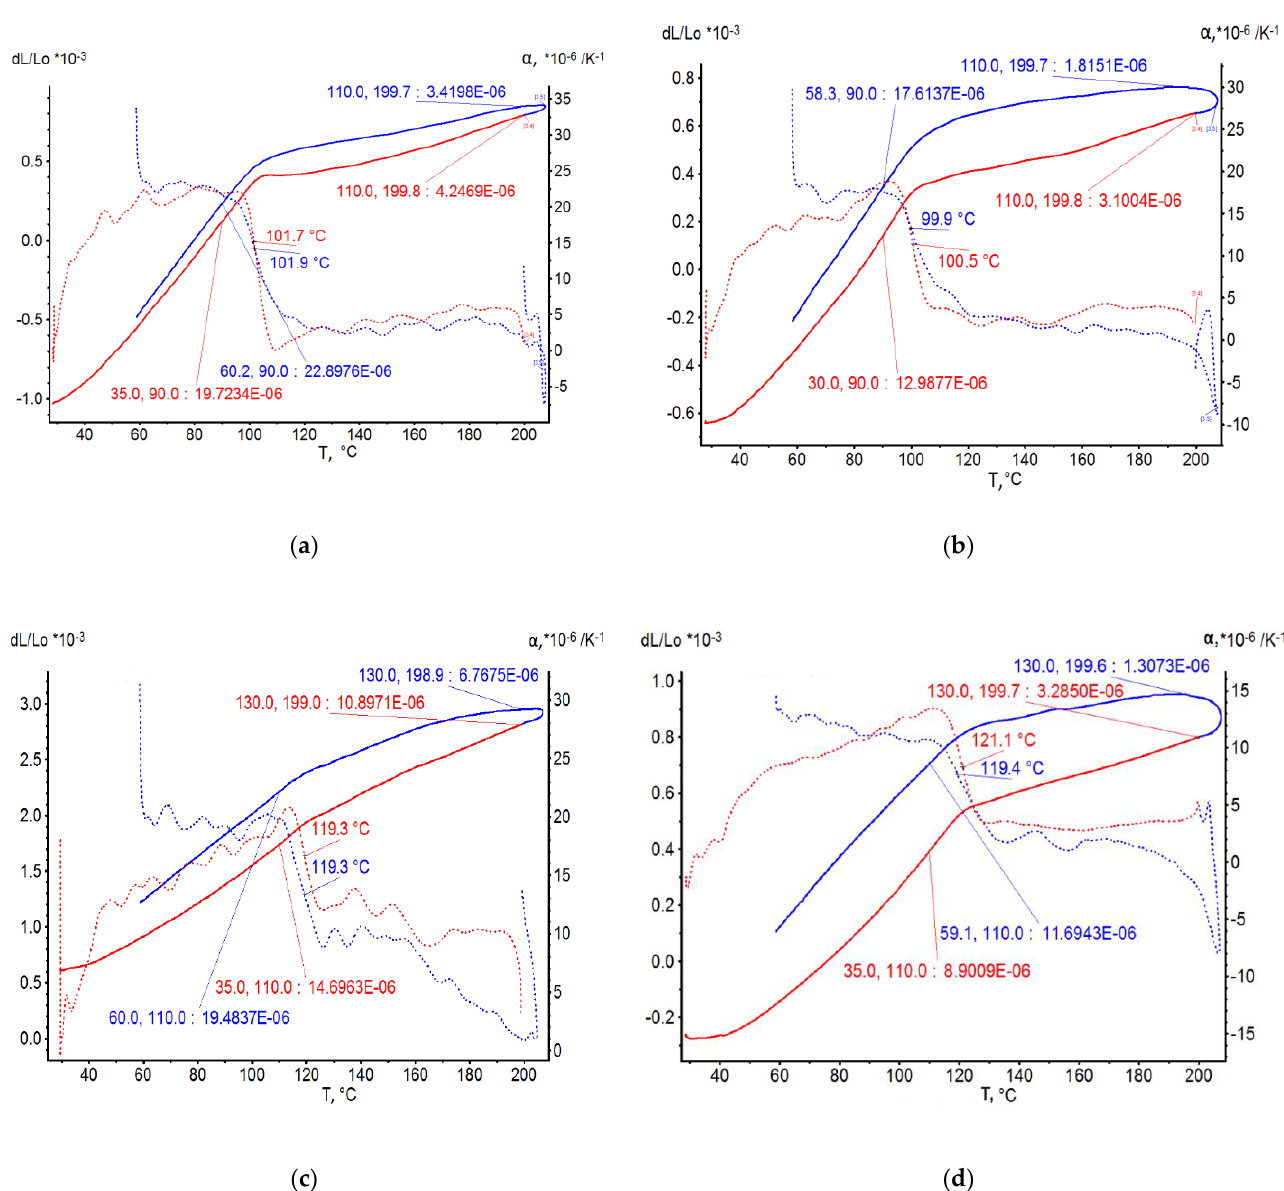
Figure 5. FRPs’ TE curves: ( a ) EP+T23, ( b ) EP+T23+FA, ( c ) EP+T23 after T-relax, ( d ) EP+T23+FA after TR.